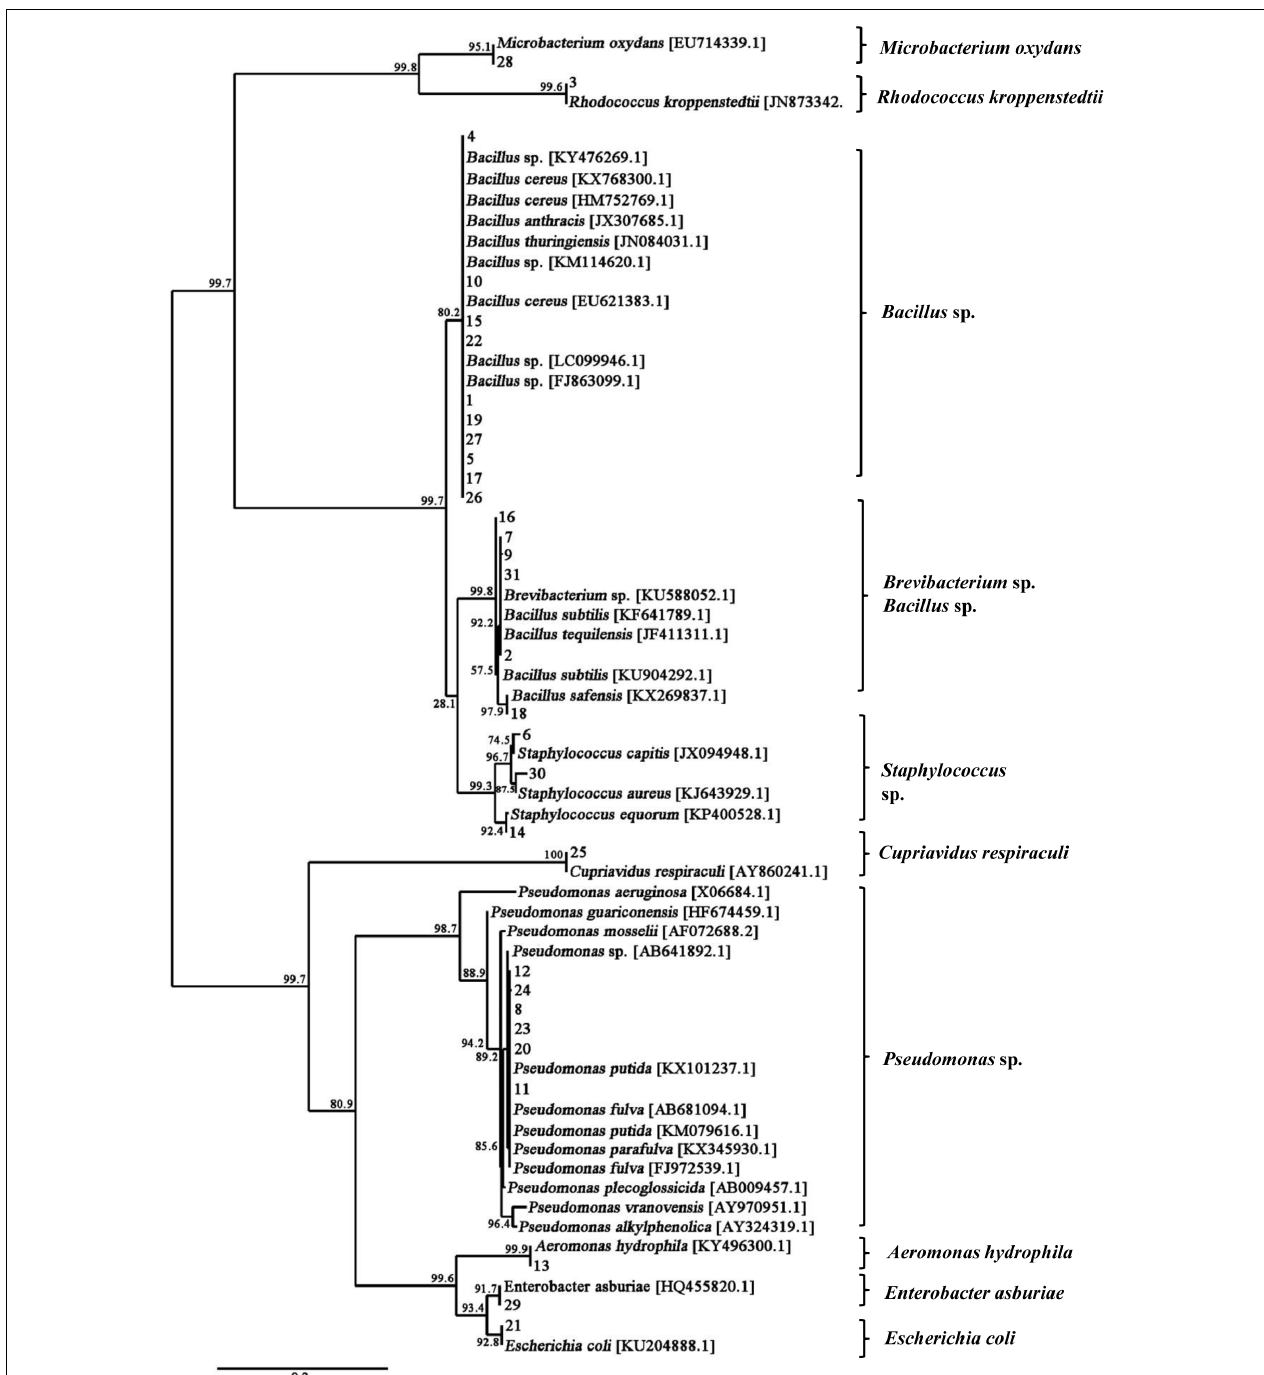
FIGURE 3 | Phylogenetic tree of 16S rDNA gene sequences showing the relationships between the bacteria isolated from the fruiting body and the reference strains. The branch length is proportional to the number of substitutions per site. Bar: 0.2 substitutions per nucleotide position.